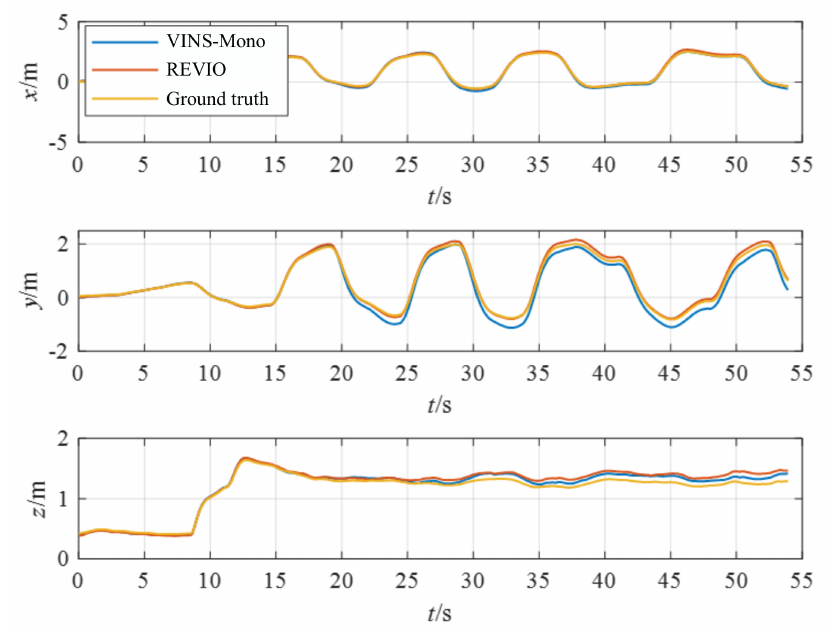
Figure 14. Comparison of REVIO versus VINS-Mono.